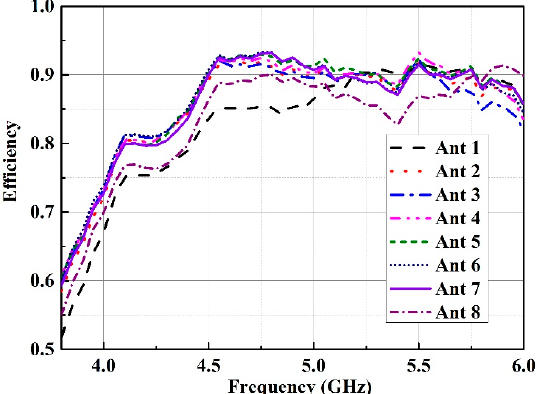
Figure 11. Measured efficiency of the eight-element MIMO antenna.